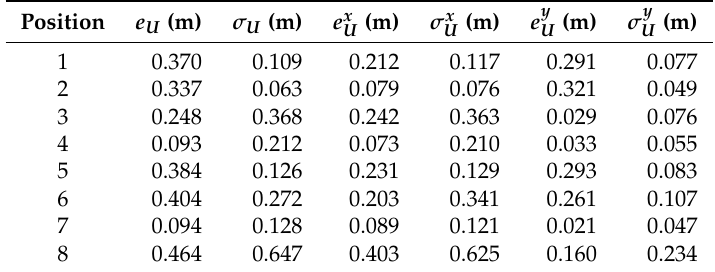
Table 5. Measured accuracy of the POST U algorithm in Scenario 2.